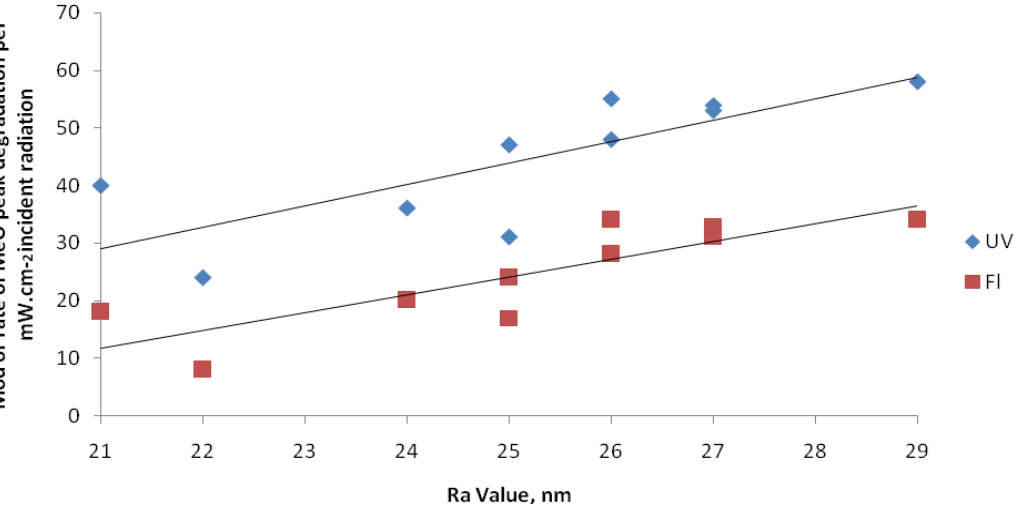
values for samples listed in Table a